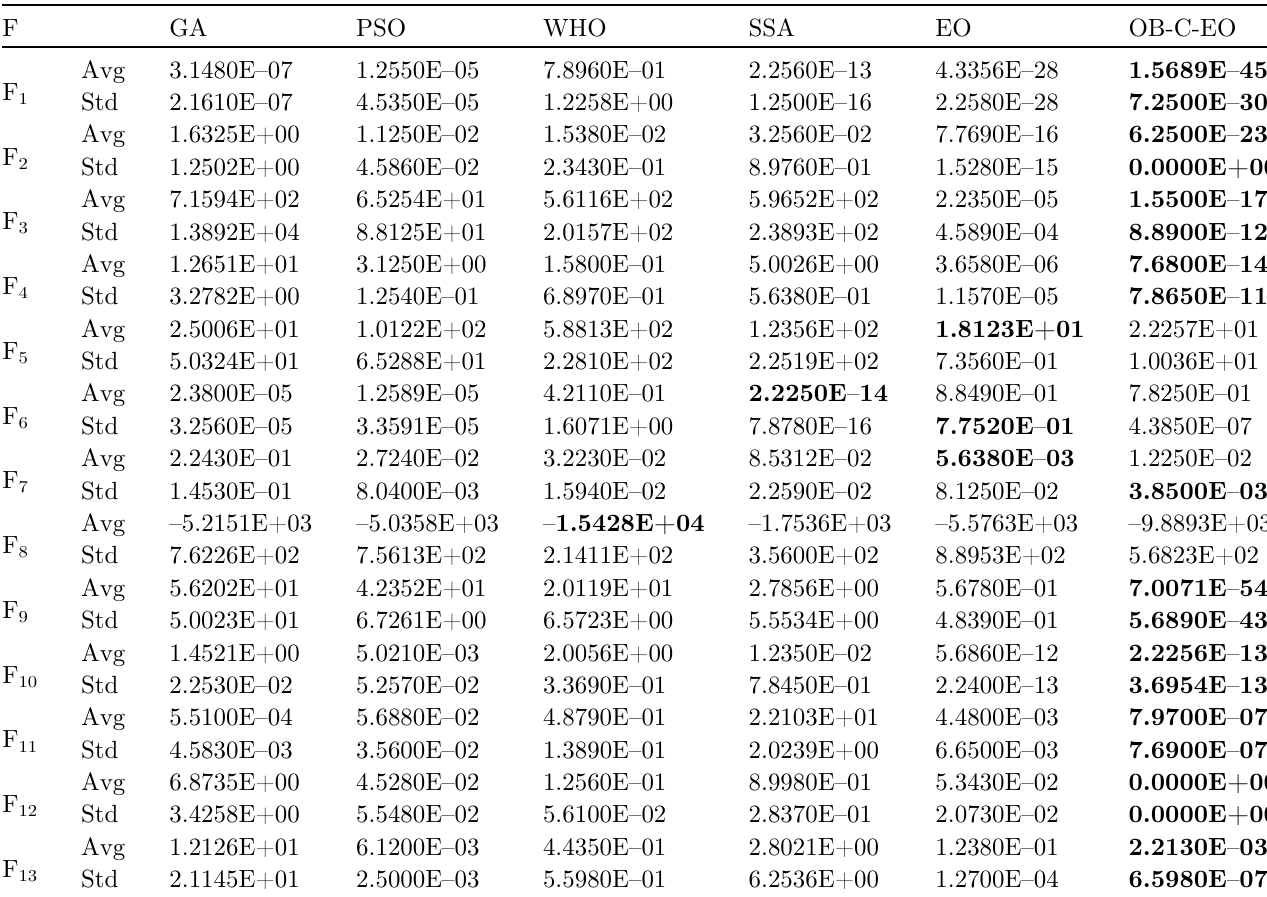
Table 5. Experimental comparison